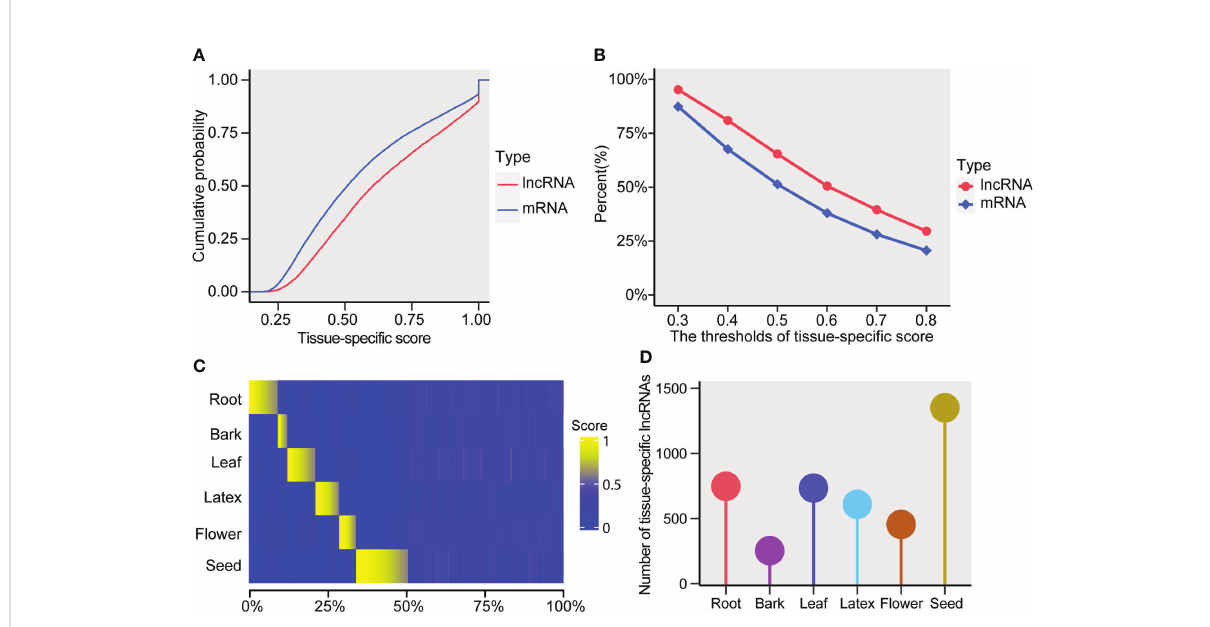
FIGURE 4 Tissue-speci fi city of the lncRNAs and mRNAs. (A) The cumulative probability of tissue-speci fi c score in lncRNAs and mRNAs. (B) Percent of tissue-speci fi c lncRNAs and mRNAs under varying thresholds of the tissue-speci fi c score. (C) Heatmap of tissue-speci fi c scores for the lncRNAs. (D) The number of tissue-speci fi c lncRNAs in the tested tissues (root, bark, leaf, latex, fl ower, and